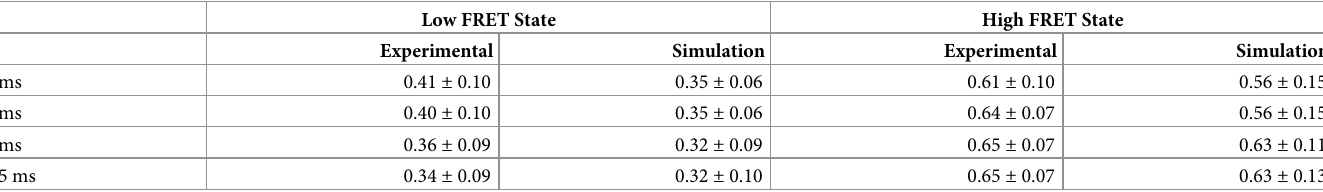
Table 1. FRET efficiencies determined from Gaussian distribution of FRET distributions. Gaussian distribution used to fit histograms is defined by Eq 7, listed are the means ± variance of the low and high FRET states corresponding to experimental smFRET and MD